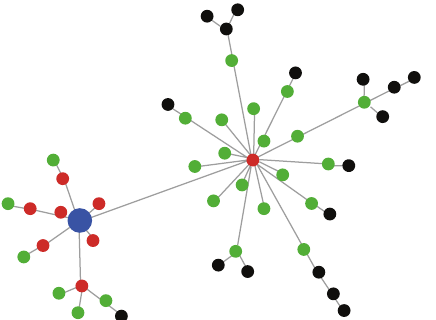
Figure 4: Neighborhood for 𝑛 = 2 . The neighbors of blue cellular include direct connect red cellular and indirect connect green